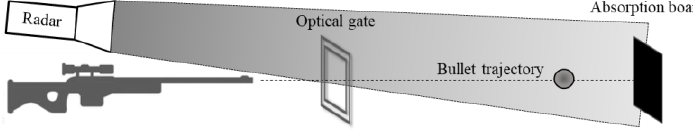
Figure 11. Illustration of the second experimental setup; the radar is placed behind the gun. Sensors 2020 , 20 , x FOR PEER REVIEW